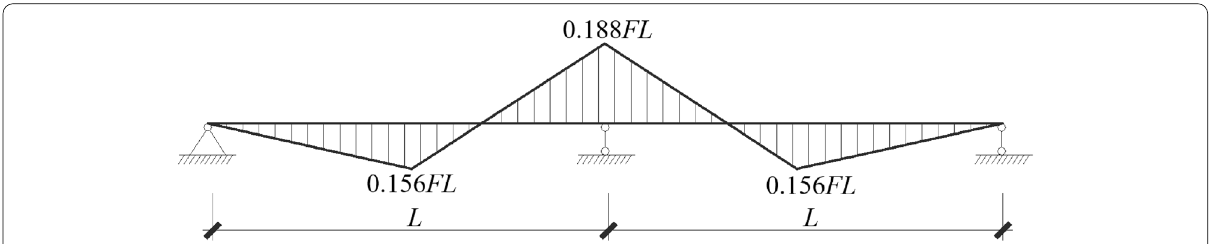
Fig. 19 Moment distribution of the continuous beam